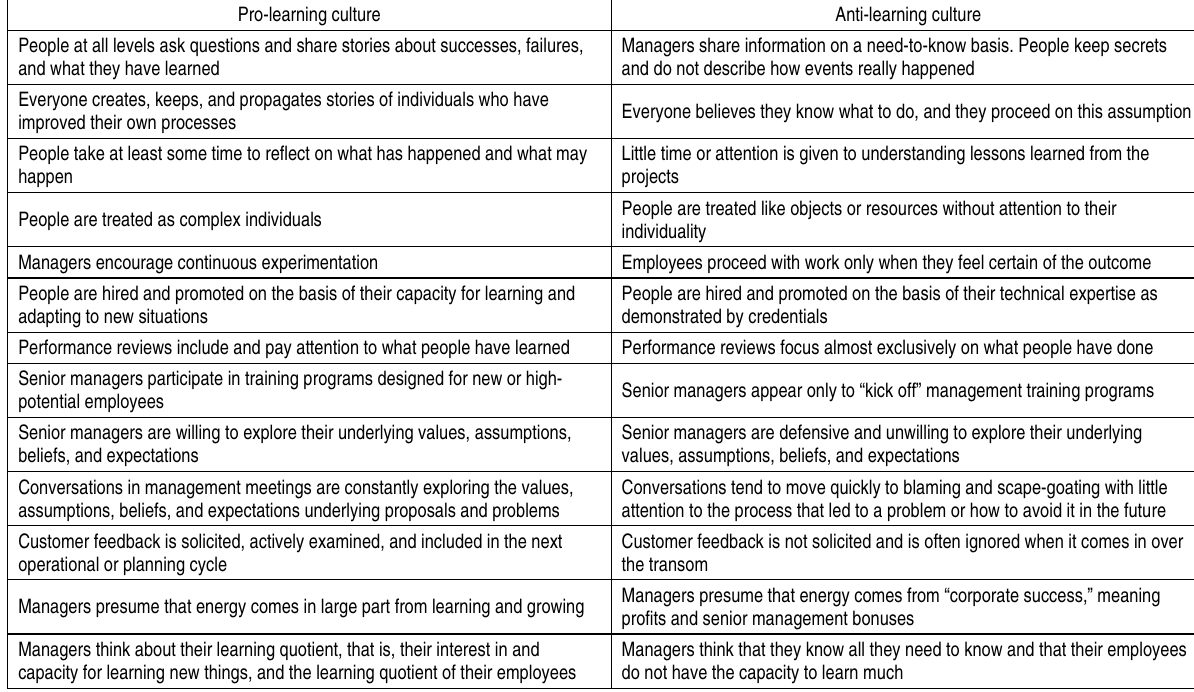
Table 3. Learning culture